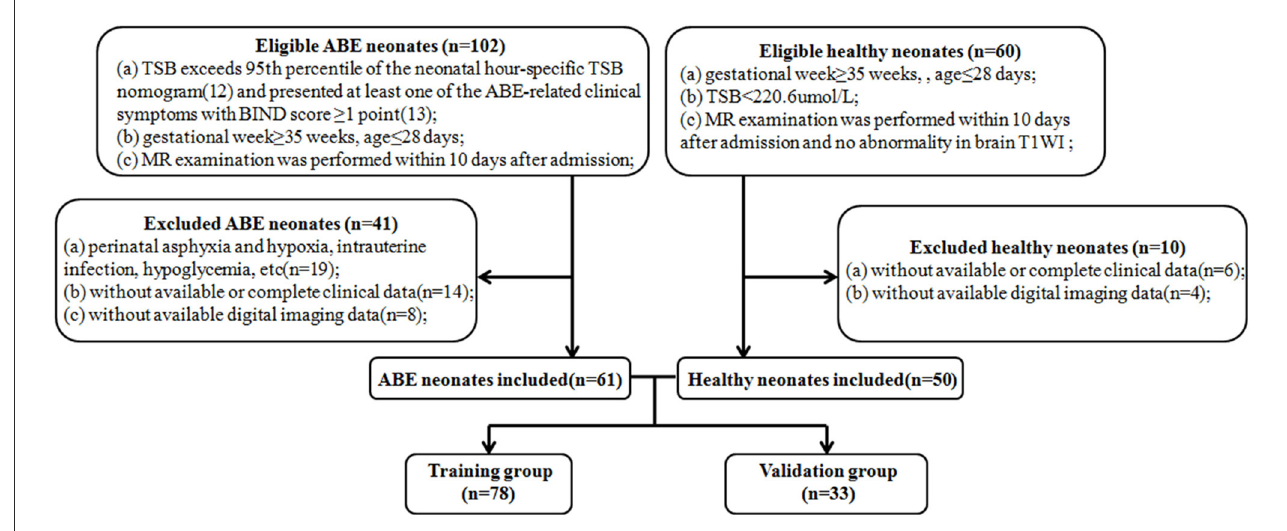
FIGURE1 Flow diagrams show the pathway of ABE and healthy neonate inclusion and exclusion. ABE, acute bilirubin encephalopathy; TSB, total serum bilirubin; BIND, bilirubin-induced neurologic dysfunction.